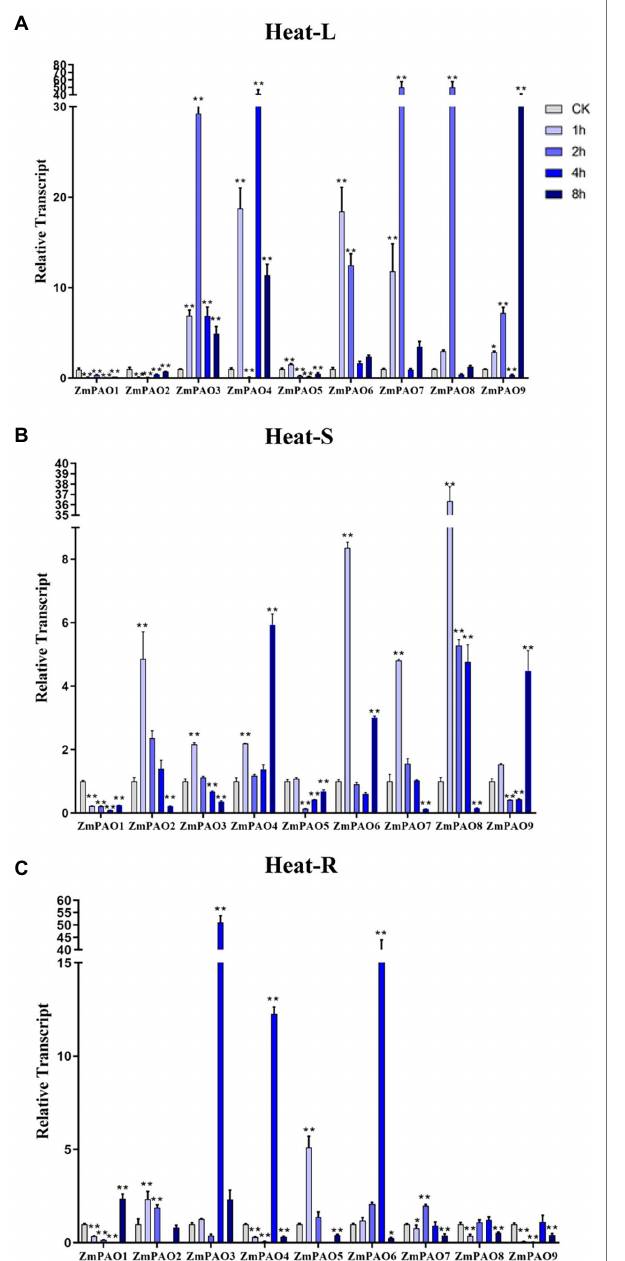
FIGURE 8 | Expression profiles of ZmPAO genes under salt stress treatment in different tissues. qRT-PCR data was normalized using ZmActin gene. (A–C) Expression profiles of ZmPAO genes under salt treatment with 200 mM NaCl in leaves, stems, and roots, respectively. Error bars are caused by three biological replicates. Asterisks above the error bars represent statistical significance using one-way ANOVA and a Fisher’s LSD. * Significantly different at p < 0.05; ** significantly different at p <